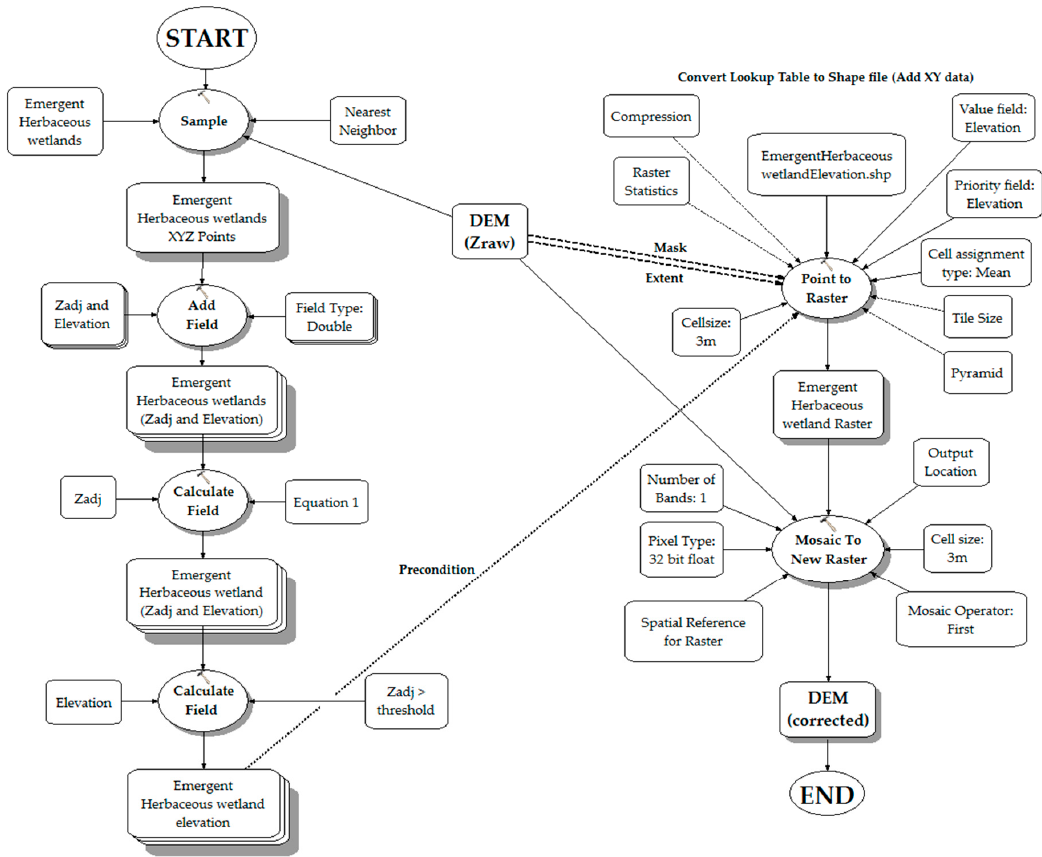
Figure 2. Schematic of the ‘DEM-correction’ tool developed in Model Builder of ArcGIS.